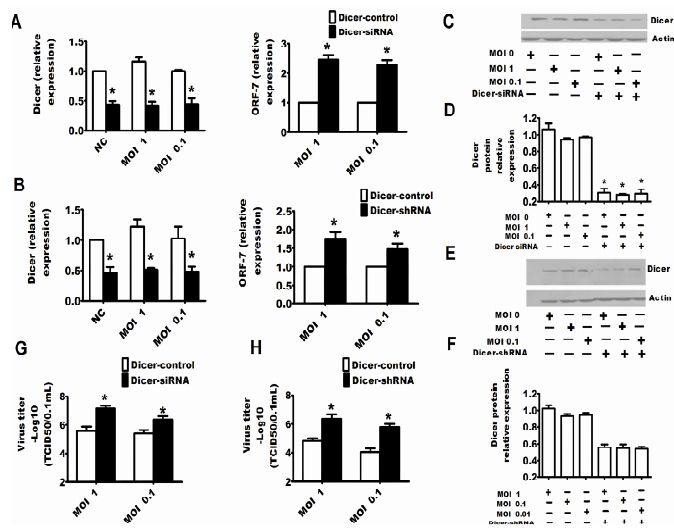
Figure 3. Dicer was involved in protection against the replication of PRRSV in PAMs. PAMs were transfected with Dicer-siRNA or Dicer-shRNA, and after 24 h, cells were infected with PRRSV at an MOI of one or 0.1. Additionally, 24 h after the infection of PRRSV, the cells were ready for qRT-PCR of Dicer and PRRSV ORF-7 ( A , B ) or the cells were collected for Western blots for Dicer ( C , E ). Western blot results for Dicer were quantified by Quantity One Software ( D , F ). Viral yields in the supernatants were also quantified by TCID 50 ( G , H ). The experiments were repeated three times. The results are from one of three independent experiments with similar observations. * p <